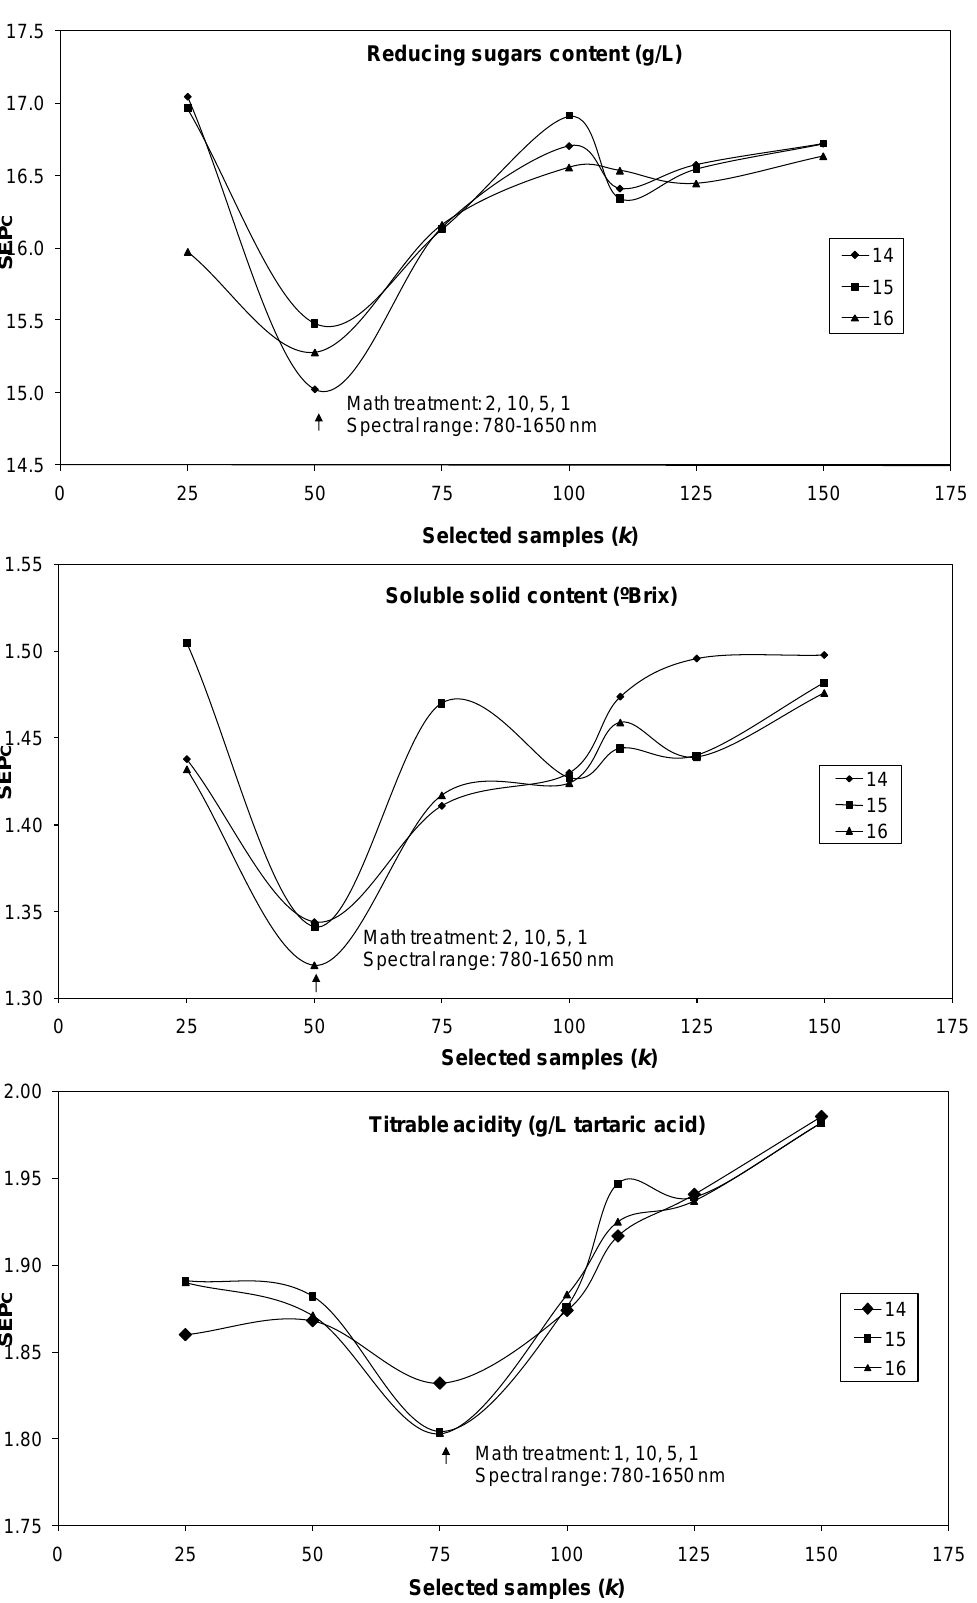
Figure 1. Best SEP values for the prediction of quality parameters in intact grapes using c the LOCAL algorithm for the different selected samples values ( k ), PLS factors ( l ), the best mathematic treatments developed and spectral ranges. ( ) 14 PLS factors; ( ) 15 PLS factors, ( ) 16 PLS